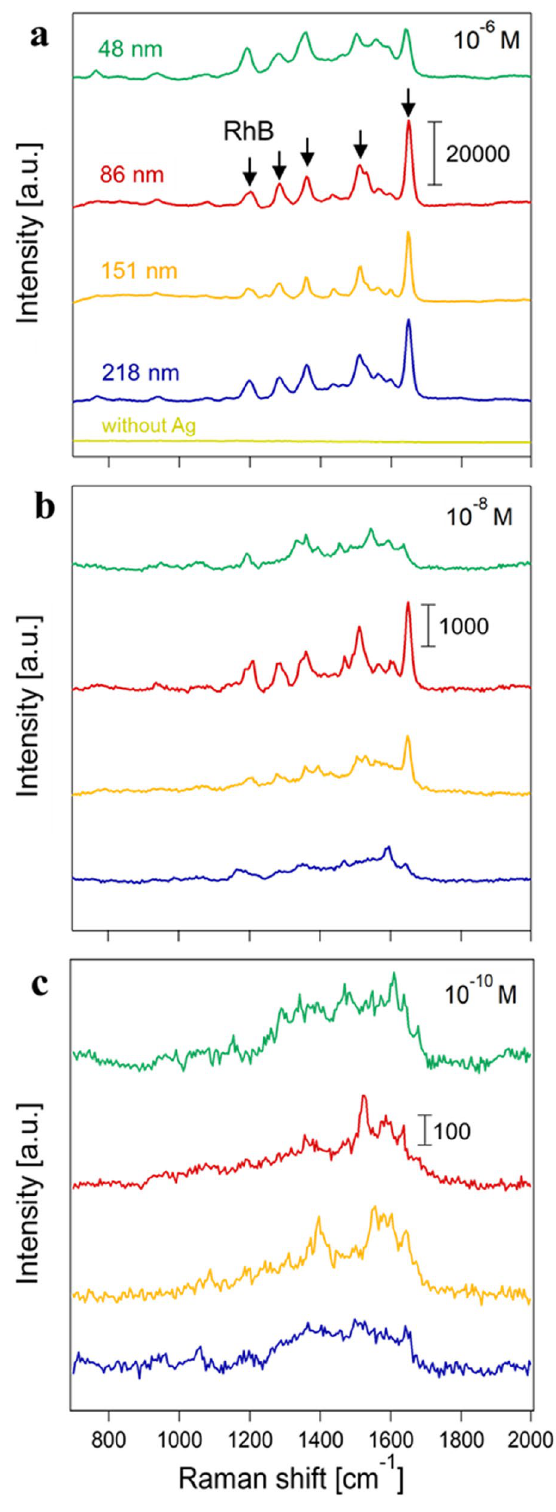
Figure 4. SERS spectra of RhB at the ( a ) 10 −6 M, ( b ) 10 −8 M, and ( c ) 10 −10 M concentrations. The arrows indicate the representative RhB peaks (Table